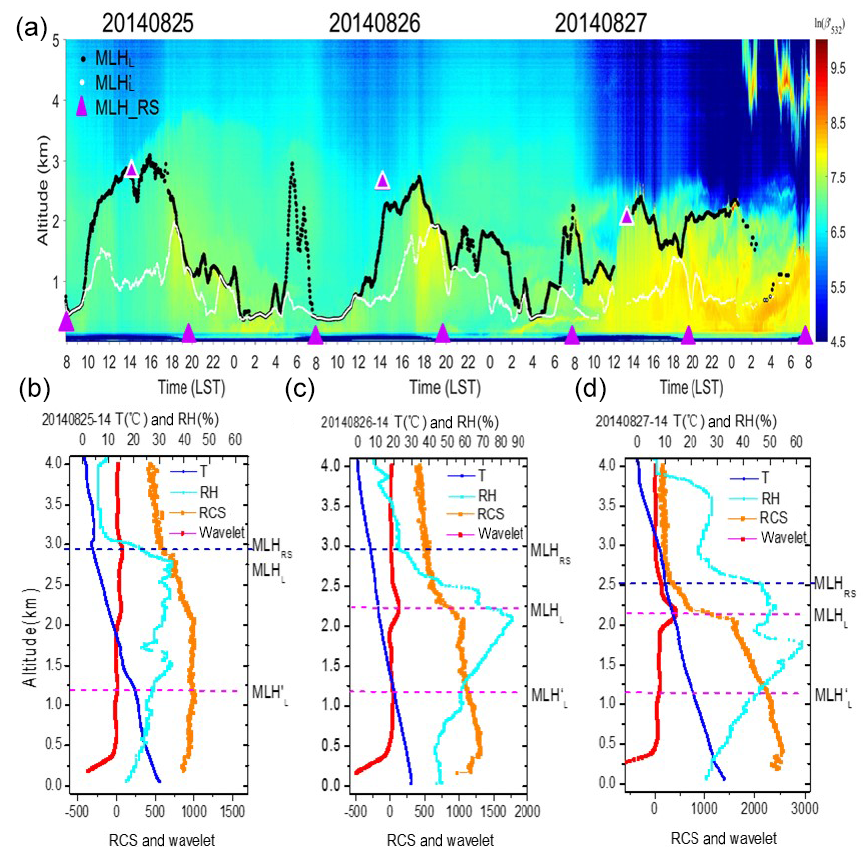
Figure 2. Similar to Fig. 1, but for (a) 25–27 August 2014, and with vertical profiles for (b) 14:00LST on 25 August 2014, (c) 14:00LST on 27 August 2014 and (d) 20:00LST on 27 August